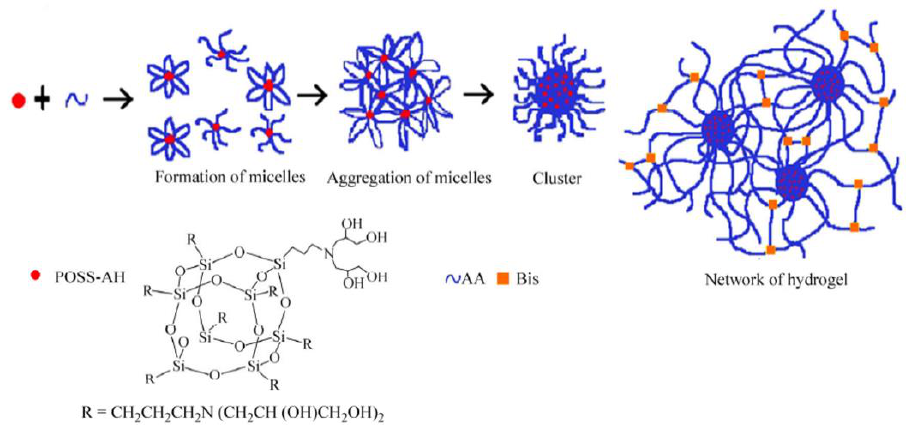
Figure 30. Formation of a dual network in POSS-AH/PAA hydrogels. Reprinted by permission from Springer-Verlag, Chin. J. Polym. Sci . 2016, 34 , 185 – 194. Highly Stretchable and Self-healing Hydro- gels Based on Poly(acrylic acid) and Functional POSS. Yang, L.-Q.; Lu, L.; Zhang, C.-W.; Zhou, C.- R.) [100],